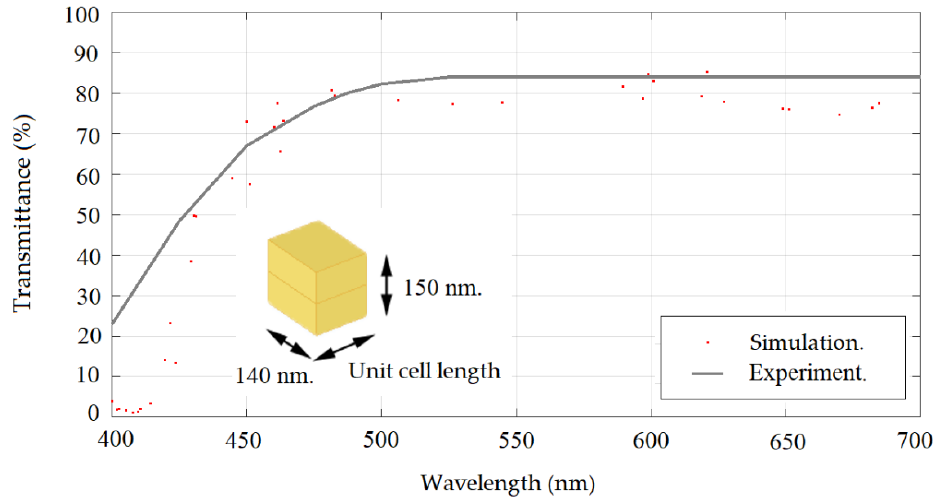
Figure 10. Comparison of our simulation and experimental results [26] using Al fiber (W = 140 nm and H = 150 nm).